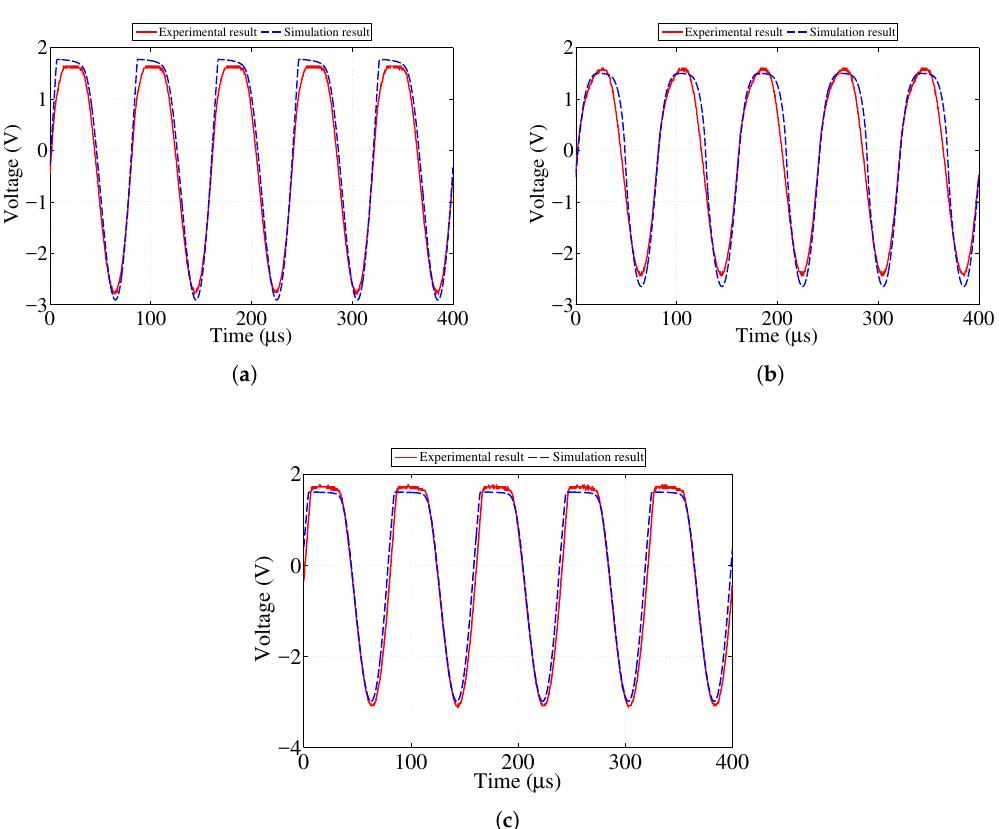
Figure 7. Simulation and experimental voltage data across 0.8 mm strip LED showing response at various resistances. ( a ) 3.8 k Ω resistance (at threshold); ( b ) 6.4 k Ω resistance (above threshold); ( c ) 0.6 k Ω resistance (below threshold).